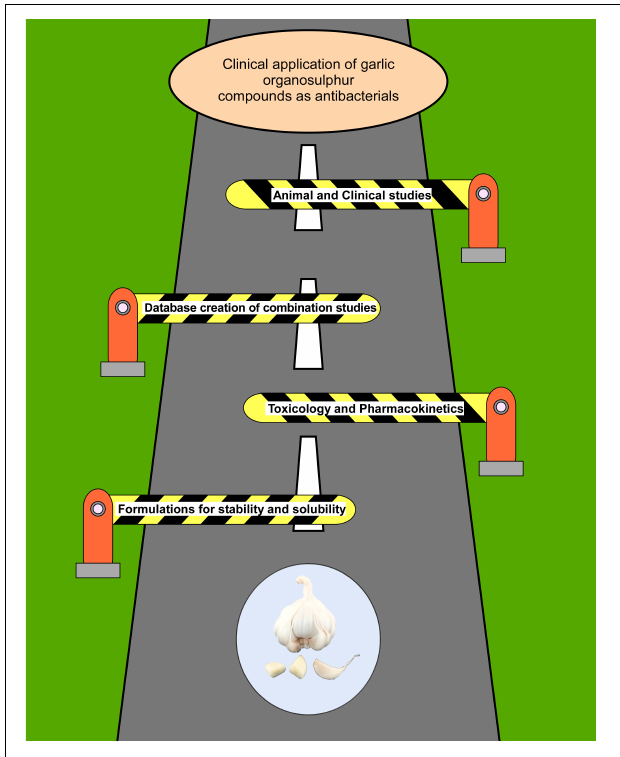
FIGURE 3 | Cartoon representation of the challenges that should be crossed for garlic/garlic compounds to be used in the clinical setting as antibacterials. The road to developing garlic/garlic compounds into novel clinically relevant antibiotics is subject to crossing the barrier shown in the cartoon, which are as follows: (1) the development of new formulations that would improve the specificity, stability, and solubility of garlic organosulfur compounds; (2) to access the safety and bioavailability of organosulfur compounds by performing toxicology and pharmacokinetic studies with various compounds administered through different routes; (3) to avoid repetition and encourage in vivo studies, creation of a database to record the in vivo and in vitro antibacterial studies of garlic compounds alone and along with other antibiotics or phytochemicals; and (4) more pre-clinical and clinical studies should be performed to access the safety and efficacy of these compounds. Research in these areas will ensure the use of garlic-based novel antibacterials in the clinical